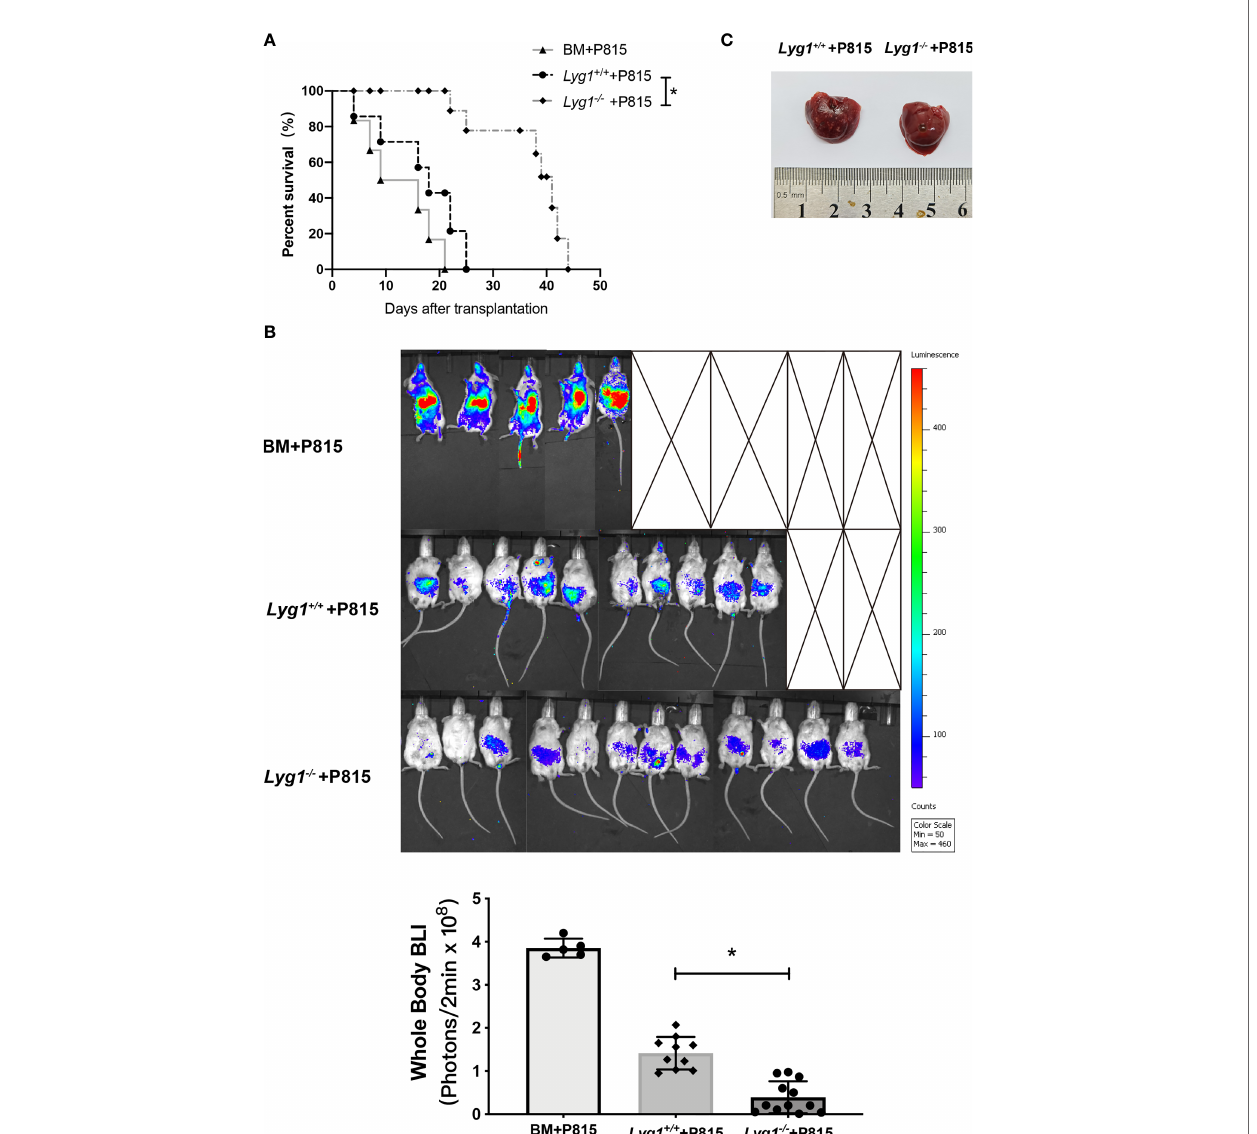
FIGURE 8 | LYG1 de fi ciency in donor T cells preserved GVT response. Lethally irradiated BALB/c mice were reconstituted with 5 × 10 6 B6 BM with or without 3 × 10 6 T cells from Lyg1 +/+ or Lyg1 -/- mice, followed by 2.5 × 10 4 P815 cells (H2Kd) injected intravenously. (A) Survival after transplantation was monitored. (B) Tumor growth was monitored using bioluminescence imaging on day 14. Bioluminescence was quanti fi ed using whole body with Living Image software. Whole body images are shown and statistical results of average bioluminescence intensities are expressed as the mean ± SD, *p < 0.05 compared with Lyg1 +/+ group. (C) Livers were excised when the mice died or on day 14 after transplantation. n = 12 for Lyg1 +/+ or Lyg1 -/- mice group, n = 10 for BM group. *p < 0.05 compared with Lyg1 +/+